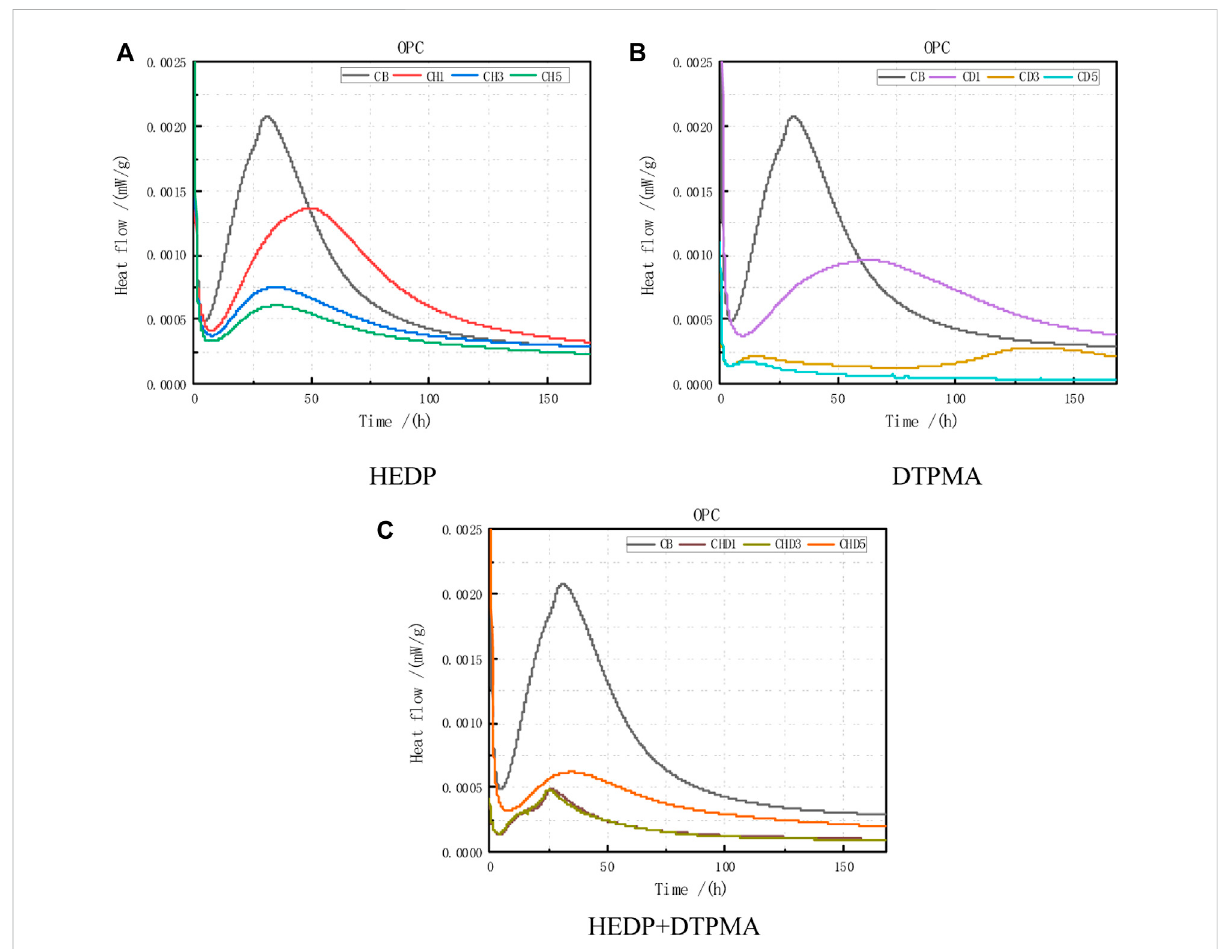
FIGURE 7 Heat fl ow data obtained from OPC combined with the following: (A) HEDP, (B) DTPMA, and (C) HEDP + DTPMA.